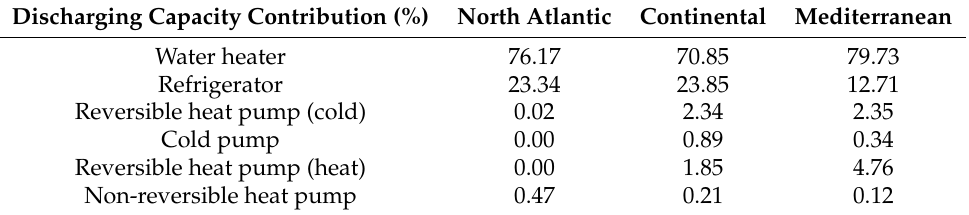
Table 7. Contribution percentage of each type of TCL to discharging capacity per climate area in 2019.